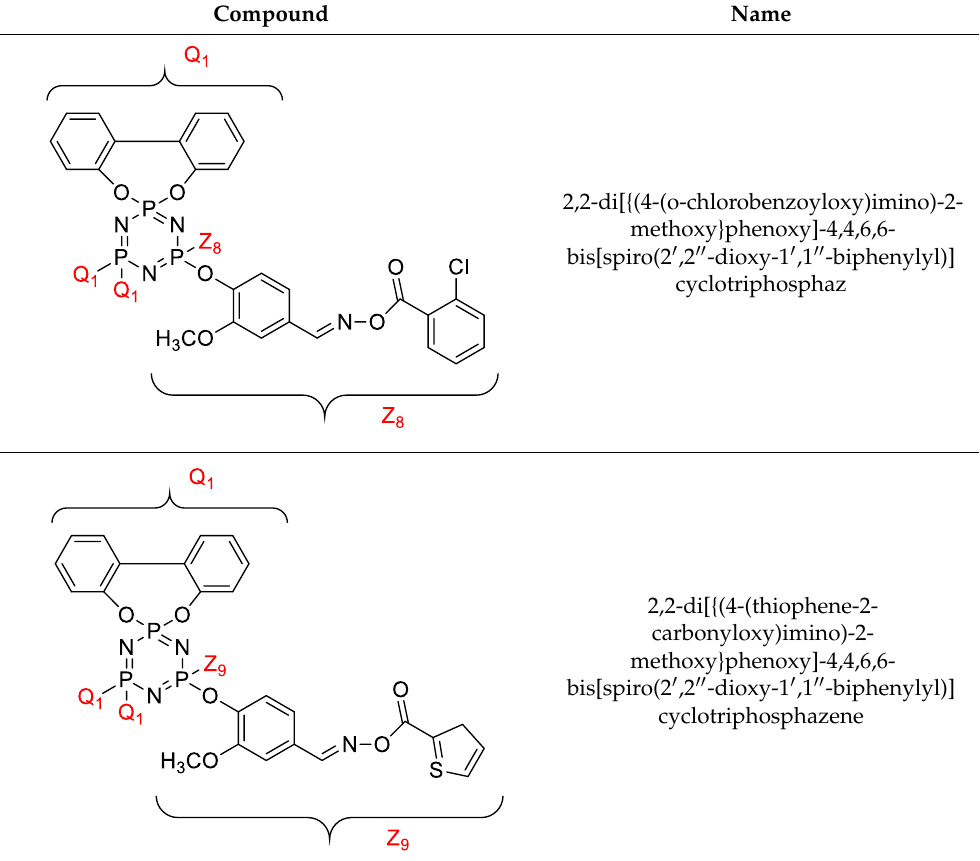
Table 4. Reported study of cyclotriphosphazene and their dielectric properties